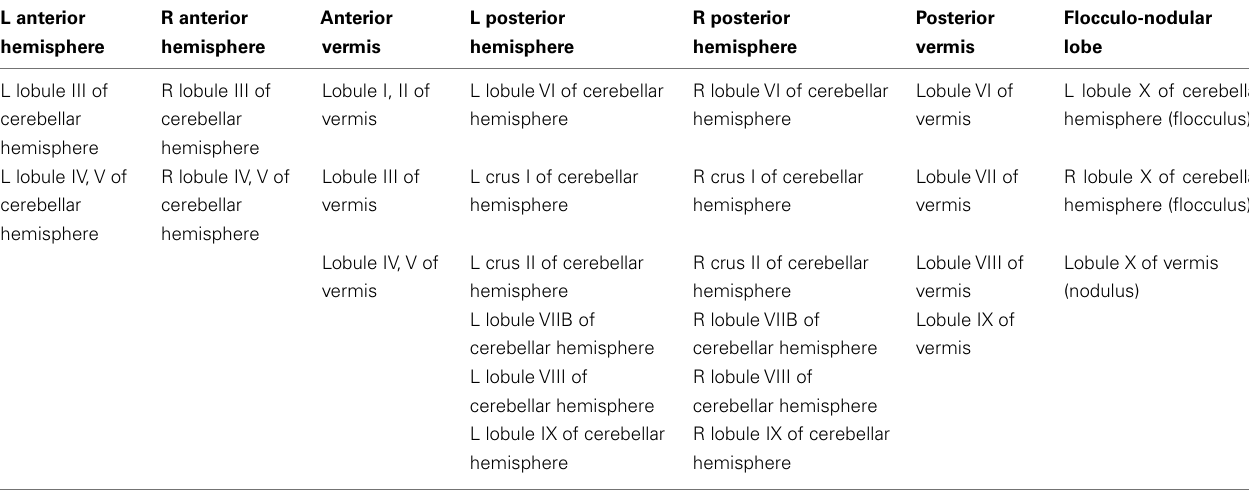
Table 2 |Automated anatomical labeling regions per cerebellar